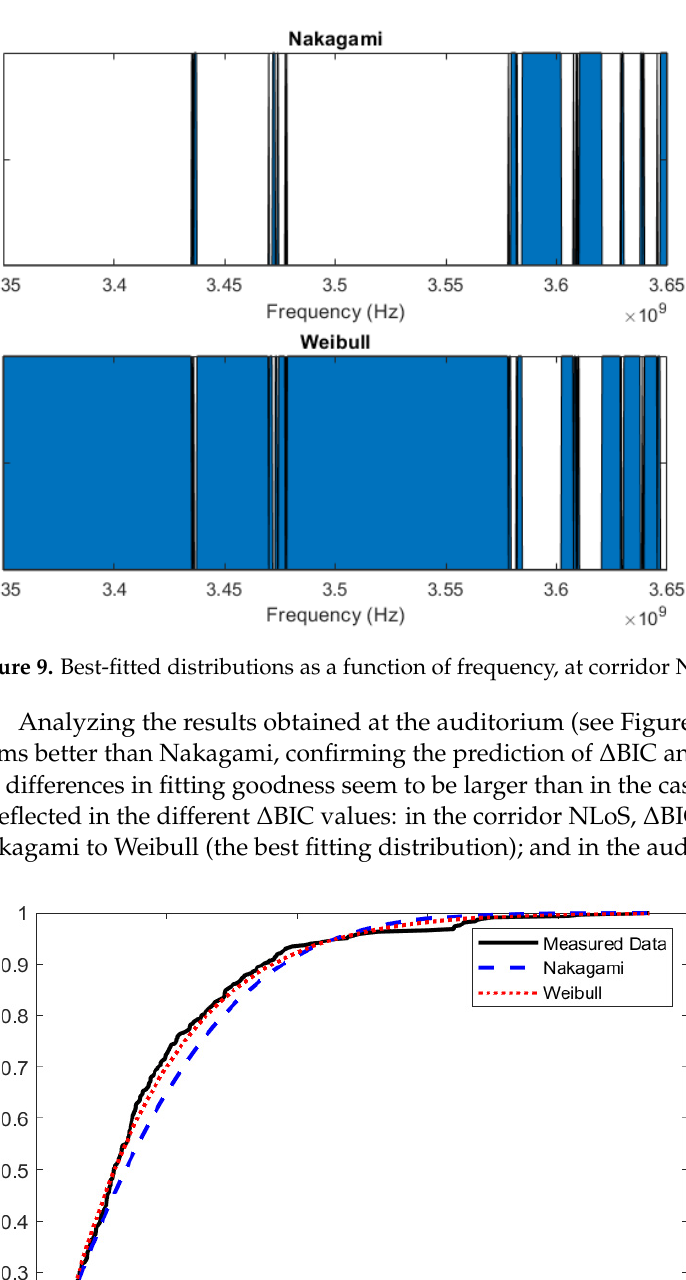
Figure 8. Cumulative distribution functions fitting fast variations within the corridor at 3.5 GHz in NLoS conditions.